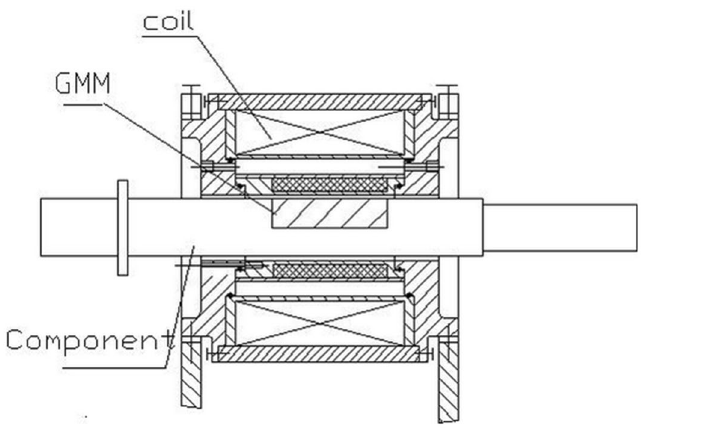
Figure 1. Structure of the smart